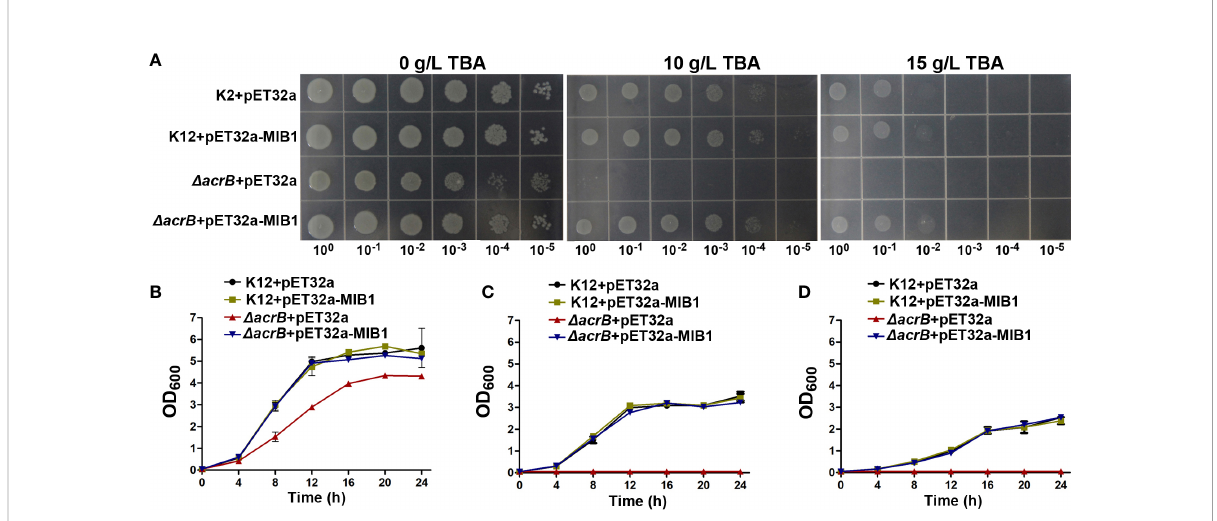
FIGURE 5 Analysis of MIB1 transport function in Escherichia coli. (A) The effect of MIB1 expression on the growth of ( E ) coli cells under TBA treatment on the LB plate. ( E ) coli cells were spotted on the LB plate with 0, 10, and 15 g/L TBA for 24 h. 10 0 , 10 − 1 , 10 − 2 , 10 − 3 , 10 − 4 , and 10 − 5 represented dilution series. (B – D) The effect of MIB1 expression on the growth curve of ( E ) coli cells under TBA treatment . (E) coli cells were inoculated in liquid LB medium with 0 (B) , 10 (C) , and 15 (D) g/L TBA for 24 h. The data were means ± SD ( n = 3).